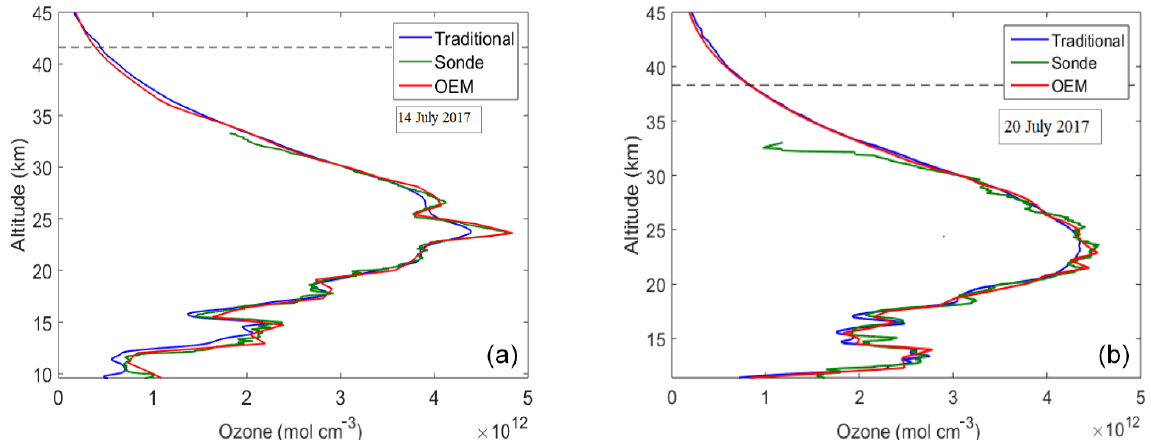
Figure 13. (a) OEM ozone retrieval on the night of 14 July 2017 (red curve) compared to the ozonesonde profile (green curve) and the traditional ozone retrieval (blue curve). (b) OEM ozone retrieval on the night of 20 July 2017 (red curve) compared to the ozonesonde profile (green curve) and the traditional ozone retrieval (blue curve). These cases demonstrate the high resolution of the OEM technique as evidenced by the excellent agreement around the ozone peak with the sonde measurement.